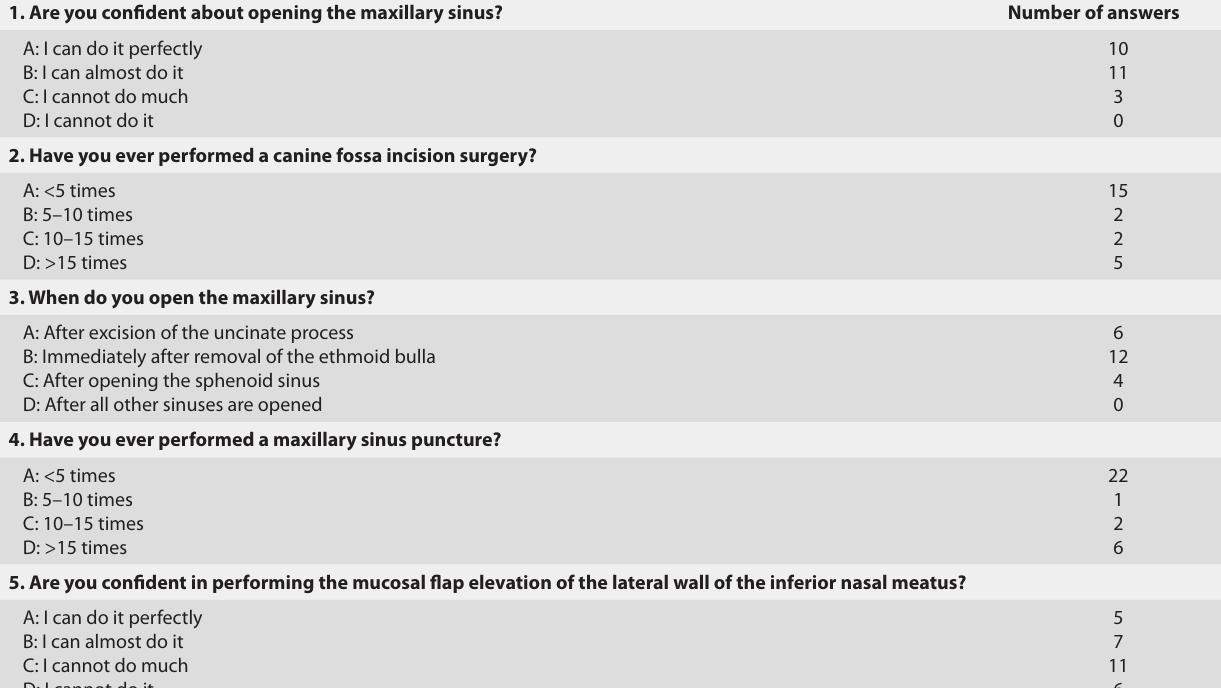
Table 1. Real-time questions during lectures. 1. Are you confident about opening the maxillary